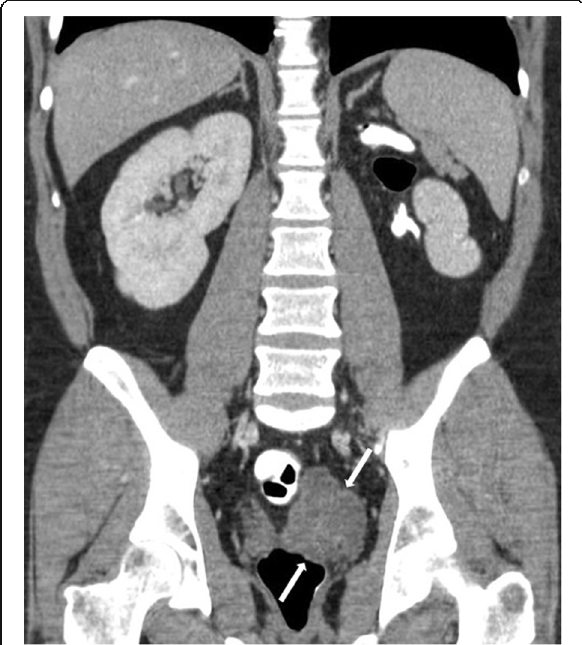
Fig. 38 A 31-year-old male patient presenting with left groin pain. Coronal plane postcontrast CT image demonstrates left renal agenesis and left seminal vesicle cysts